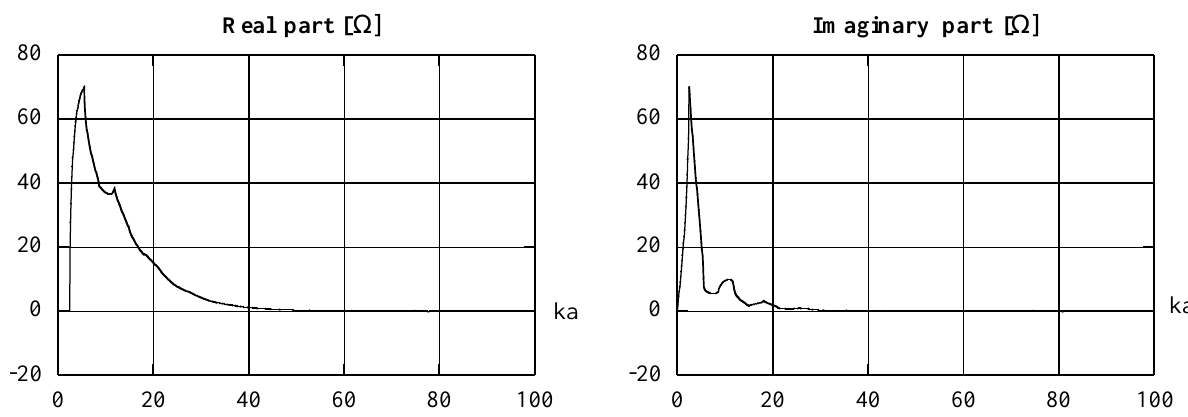
FIG. 15. Real and imaginary parts of the longitudinal coupling impedance in the case (cid:119) (cid:173) (cid:51) (cid:121) (cid:53) and bg (cid:173) (cid:49)(cid:48) .